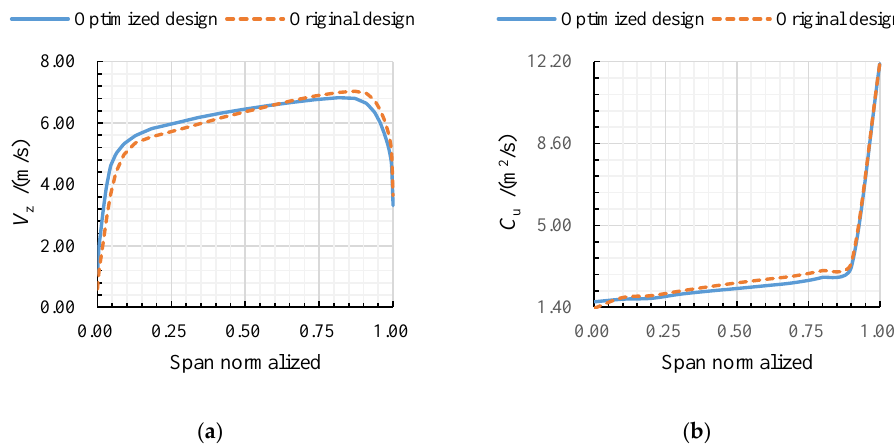
Figure 14. Comparison in the impeller outlet between the original and optimized design for the ( a ) velocity axial distribution and ( b ) circulation distribution (under the forward design flow rate).